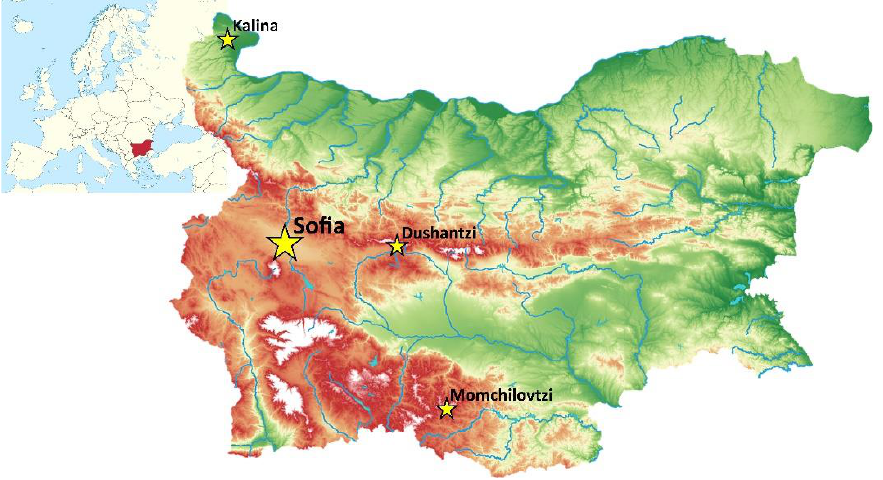
Figure 1. Locations of the apiaries from which the samples were taken.